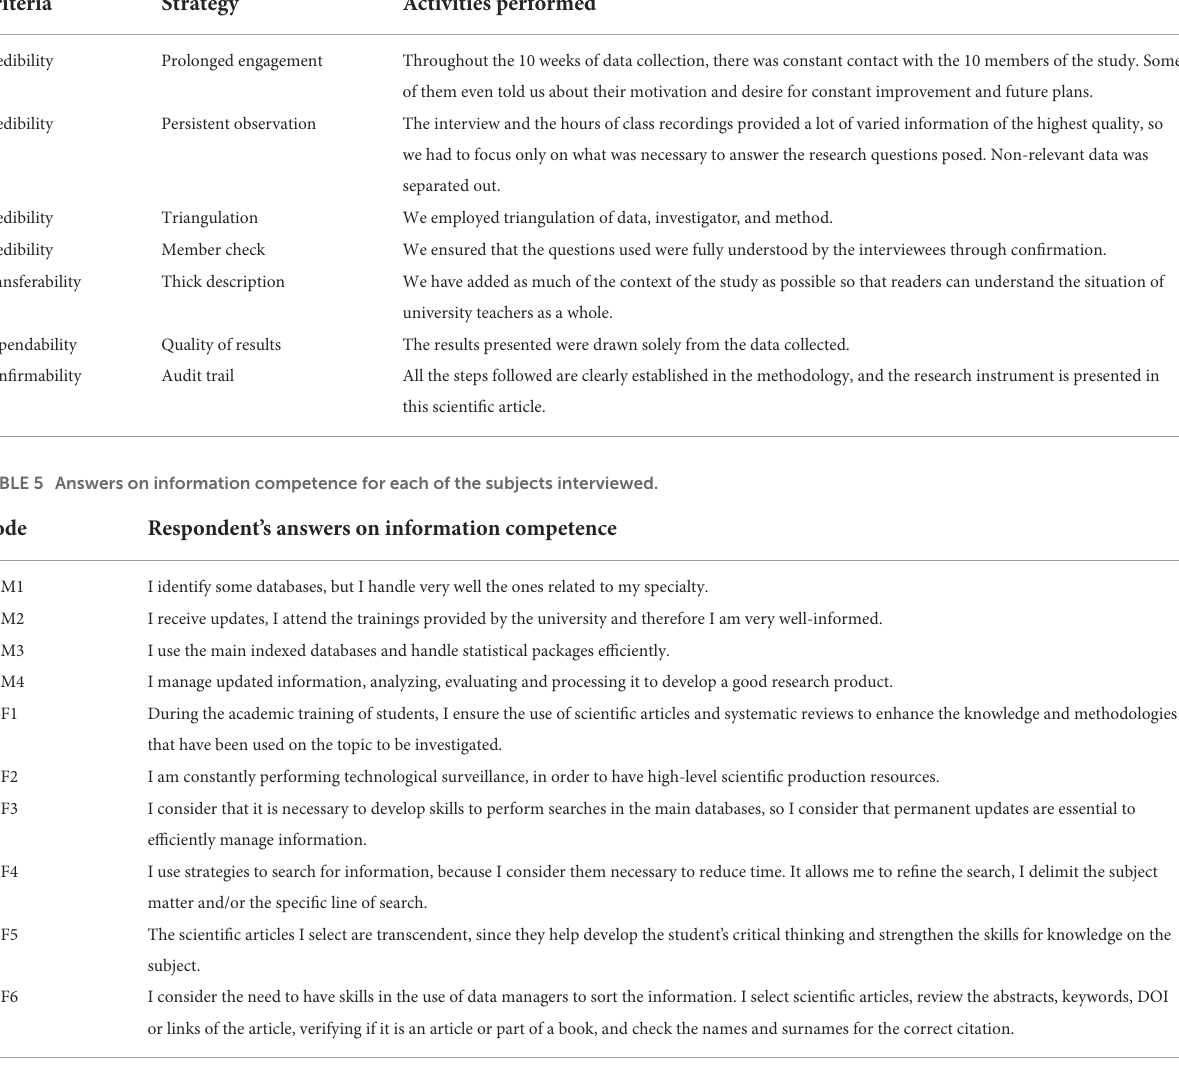
TABLE 4 Strategies followed to ensure methodological rigor and trustworthiness.